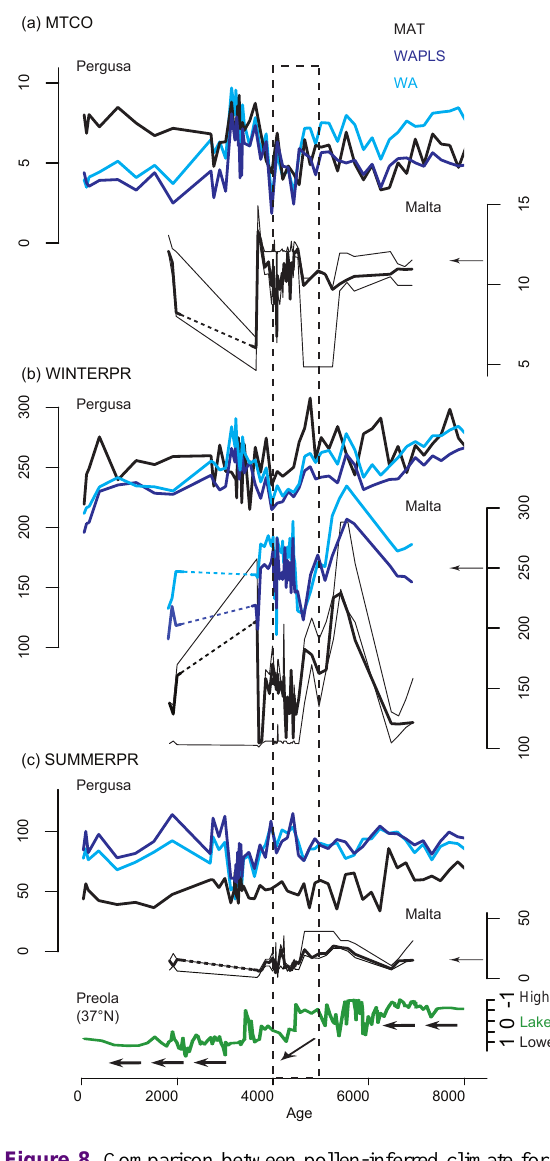
Figure 8. Comparison between pollen-inferred climate for Malta (35.9 ◦ N, Burmarrad, Malta) and Lago Pergusa (37.5 ◦ N, Sicily) us- ing MAT (modern analogue technique), WAPLS (weighted average- partial least-squares technique), and WA (weighted averaging) and lake levels for Lago Preola (37.4 ◦ N, Sicily). (a) Mean temperature of coldest month (MTCO), (b) winter precipitation (WINTERPR), (c) summer precipitation (SUMMERPR). (Malta’s present-day val- ues are indicated with an arrow on the scale